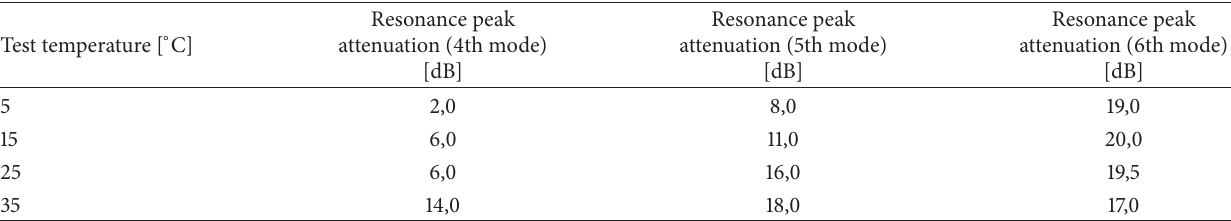
Table 3: VDVN performance (vibration attenuation), resonance peak